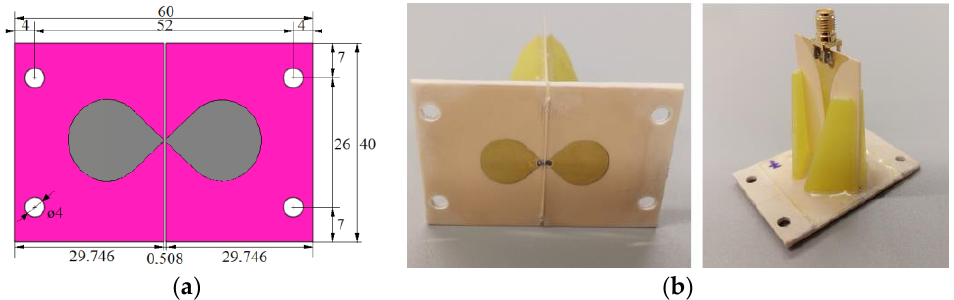
Figure 7. TBARC antenna: ( a ) Dimensions of the numerical model of the modified antenna; ( b ) Assembled modified TBARC antenna. All dimensions are expressed in mm.